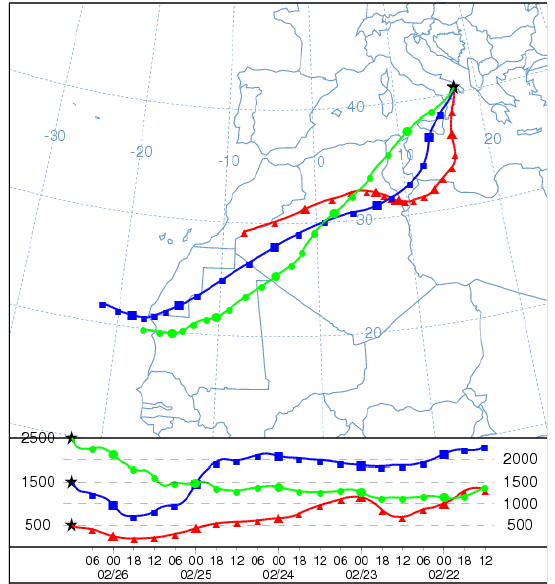
Figure 4. HYSPLIT backward trajectories ending at Taranto at 12 UTC on 26 February at 500, 1500 and 2500 m a.s.l., corresponding to the peak in the soil-related elements (see text for the details).